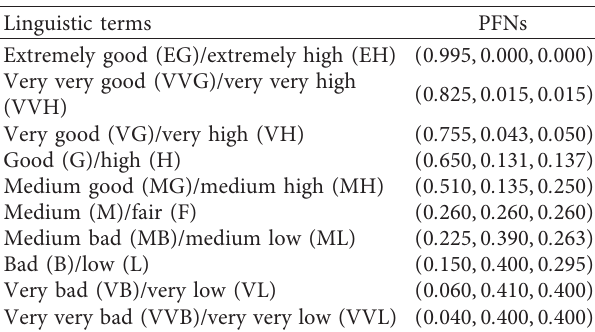
Table 14: Linguistic terms for rating the importance of alternatives.